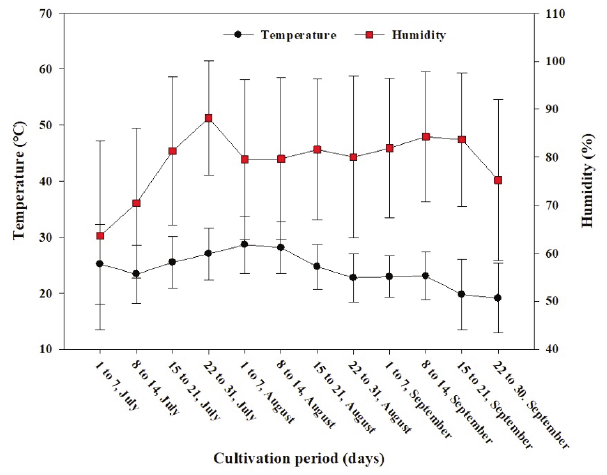
Fig. 1 ­ Principal component loading pattern of six traits of Amaranthus